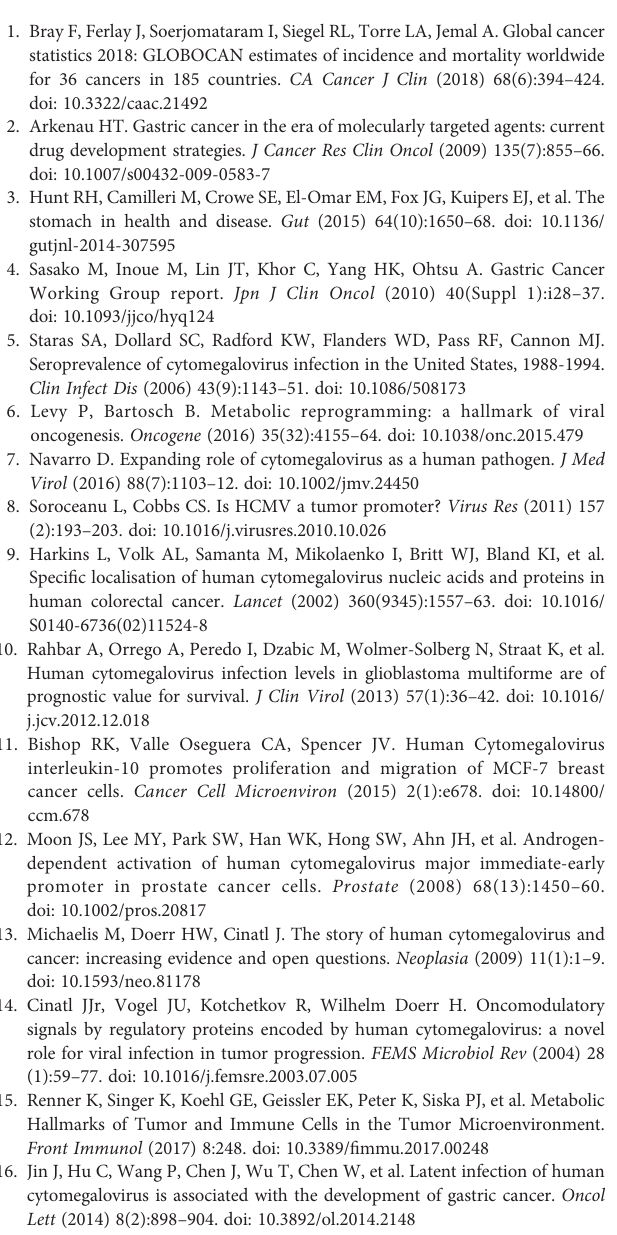
Supplementary Table 2 | The US31 interacting proteins list by LC-MS/MS.